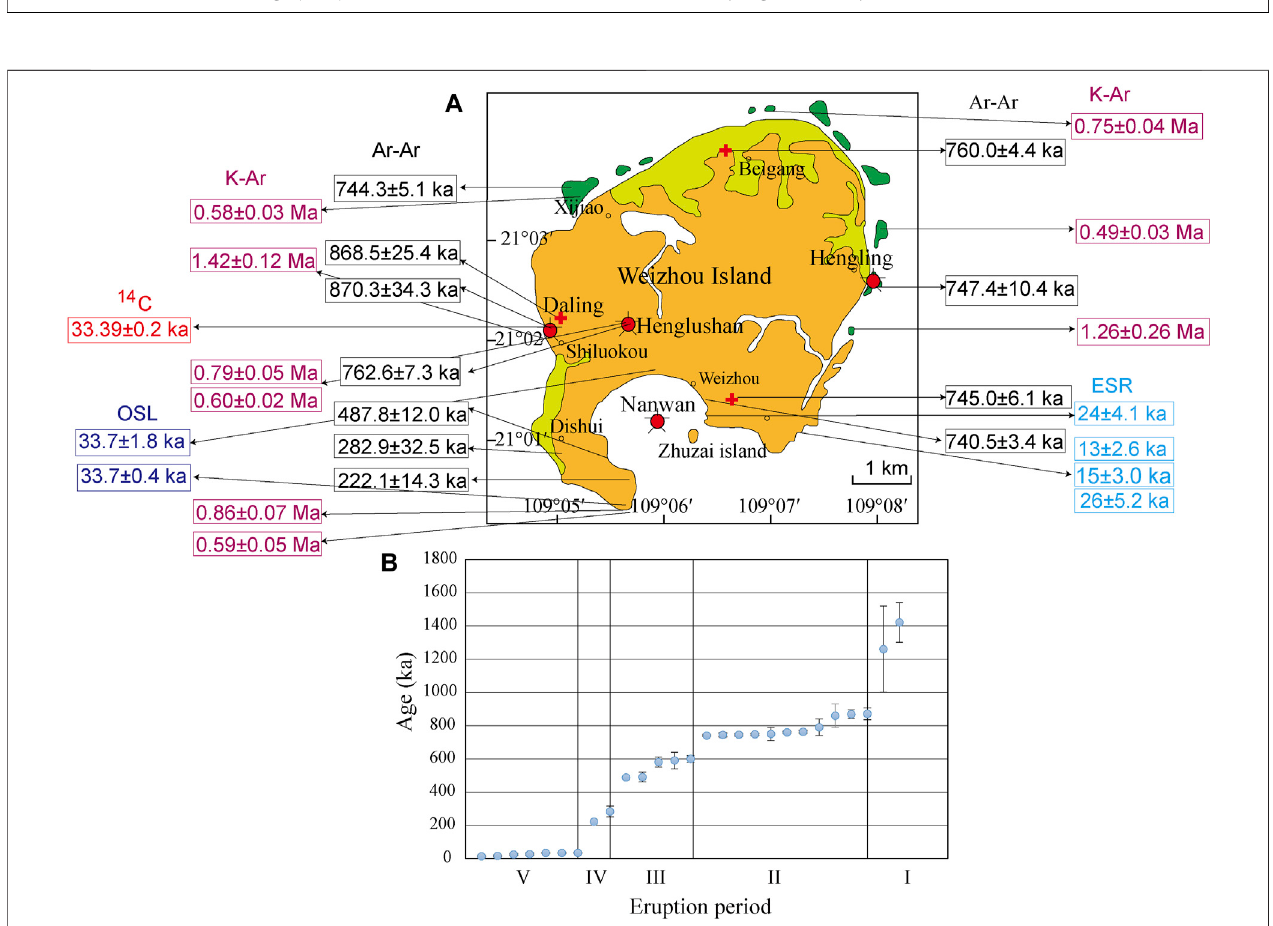
FIGURE12|(A) AgesofWeizhouislandigneousrocks. (B) Astatisticalgraphicofthedatingdata.K-Ar agesarefromFanetal.(2006) andFeng(1992),OSLages are from Fan et al. (2006), ESR ages are from Xu et al. (2020). Legends are same as Figure 1C .